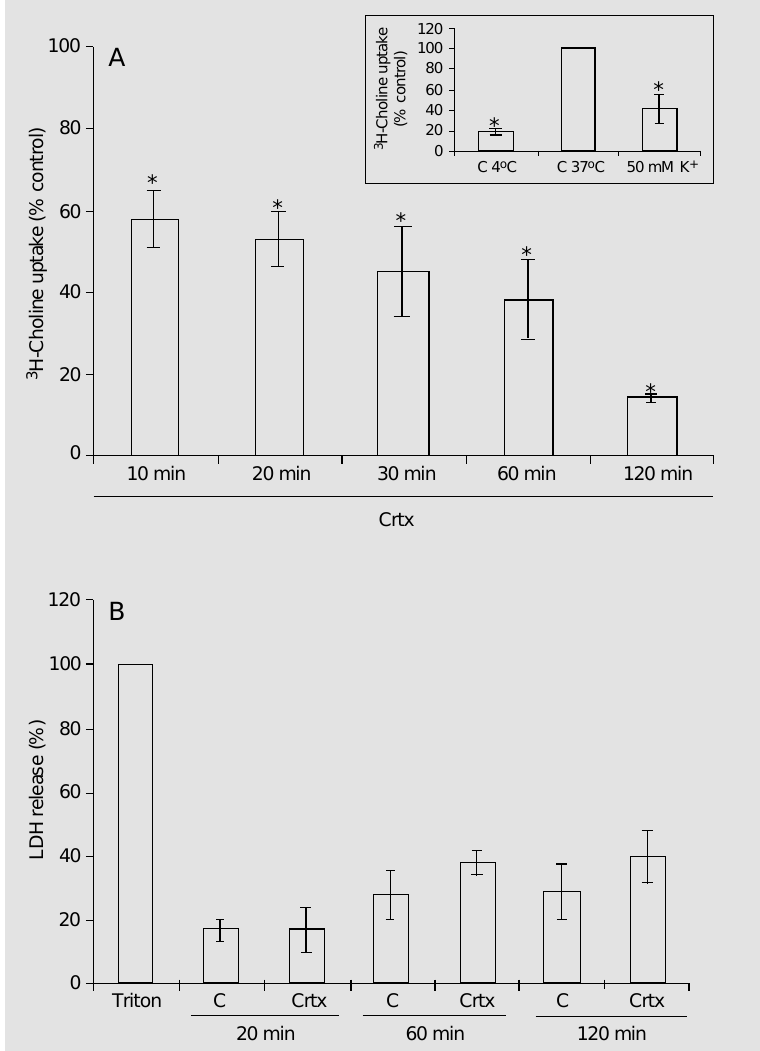
Figure 1 - Effect of pre-incubation time with crotoxin (Crtx) on 3 H-choline uptake inhibition and lactate dehydrogenase (LDH) release. A , Minces of neuromuscular preparation (40 mg in triplicate) were pre-incubated for different periods of time at 37 o C in Tyrode solution in the presence of 0.3 µM Crtx. 3 H-Choline (12 nM) was added and the uptake measured after 10-min incubation. Values are reported as percentage of total uptake (control at 37 o C) and represent the mean and standard deviation of the mean of 3 different experiments. *P<0.05 compared to control (uptake at 37 o C). Analysis of variance (P = 0) showed that there was a difference between treatments. Using the F test for repeated measures and calculating the reverse Helmet contrasts we observed that: control>10' (P = 0.012), 10'>20' (P = 0.014), 20'>30' (P = 0.009), 30'>60' (P = 0.024) and 60'>120' (P = 0.006). Inset: Control (C) values obtained in 3 different experiments at 37 o C (100% uptake) in normal and depolarizing medium (50 mM K + ) and at 4 o C in normal medium, for 10 min after the addition of 3 H-choline (12 nM). *P<0.05 compared to control at 37 o C ( t -test). B , LDH released in the control condition (C) and upon incubation with Crtx (0.3 µM) for different periods of time at 37 o C. The LDH released by the preparation treated with 1% Triton X-100 was taken as 100%. Values (mean and standard deviation of the mean of 3 different experiments) were not significant compared to the respective